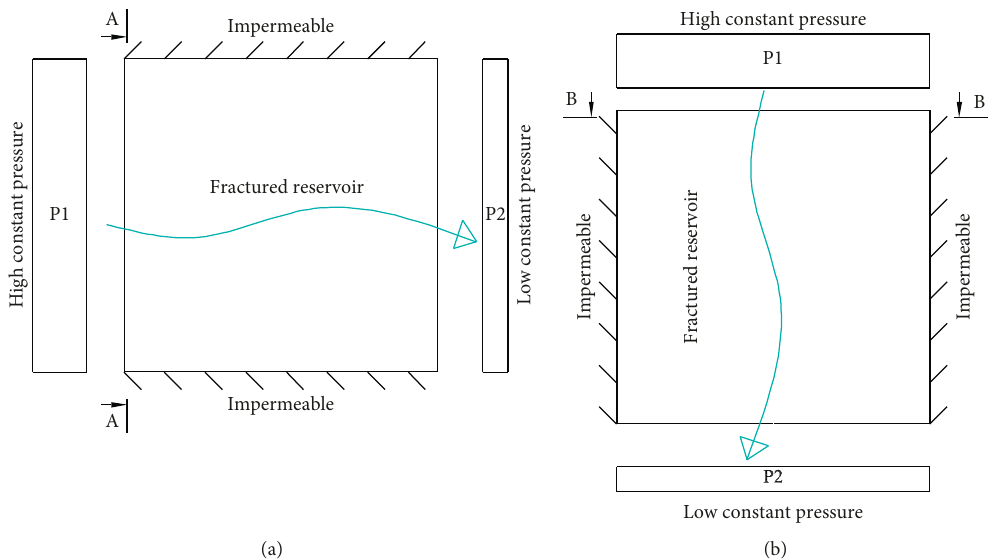
Figure 14: Boundary conditions for the effective permeability calculation: (a) x direction; (b) y direction.